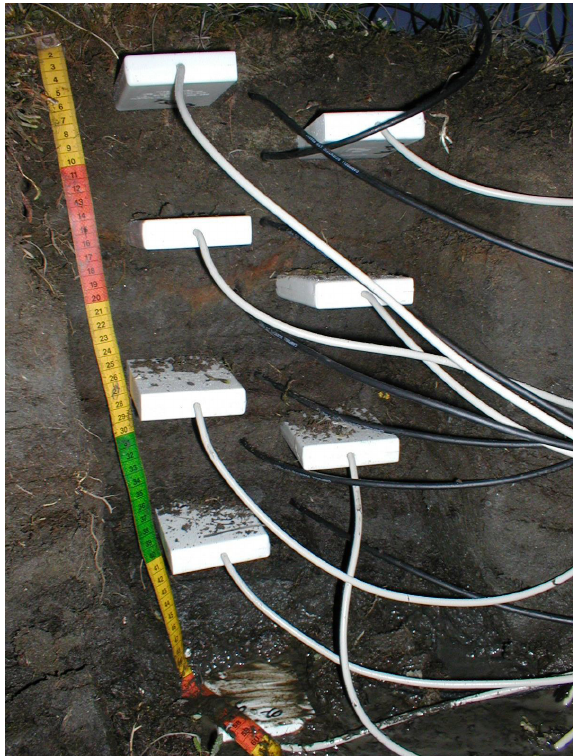
Figure B11. Soil volumetric liquid water content sensors (rim): 20 Campbell Scientific CS605 TDR probes, which are connected to a Campbell Scientific TDR100 time-domain reflectometer, installed on 24 August